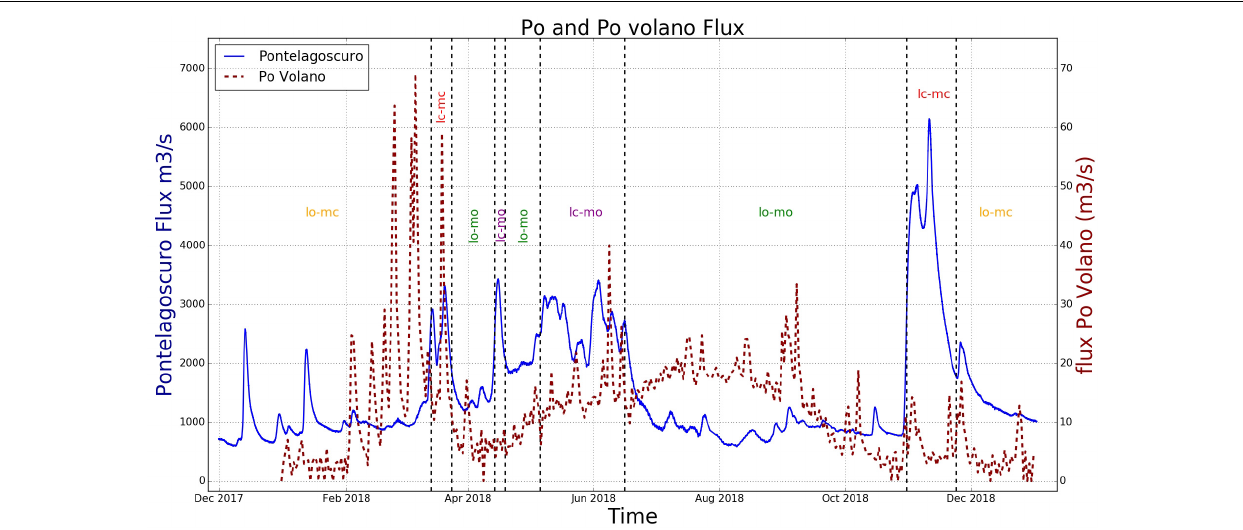
FIGURE 2 | The blue line is the observed discharge of the Po River at Pontelagoscuro, 40 km upstream the Po di Goro branch. The red dotted line is the discharge of the Po di Volano, calculated as sum of the daily volumes of water pumped into the river. The vertical dashed lines represent the different configurations of the lagoon gates: lc-mc Gorino lock and Manufatto closed and vice versa lo-mo both open; lo-mc Gorino lock open and Manufatto closed and lc-mo vice versa.